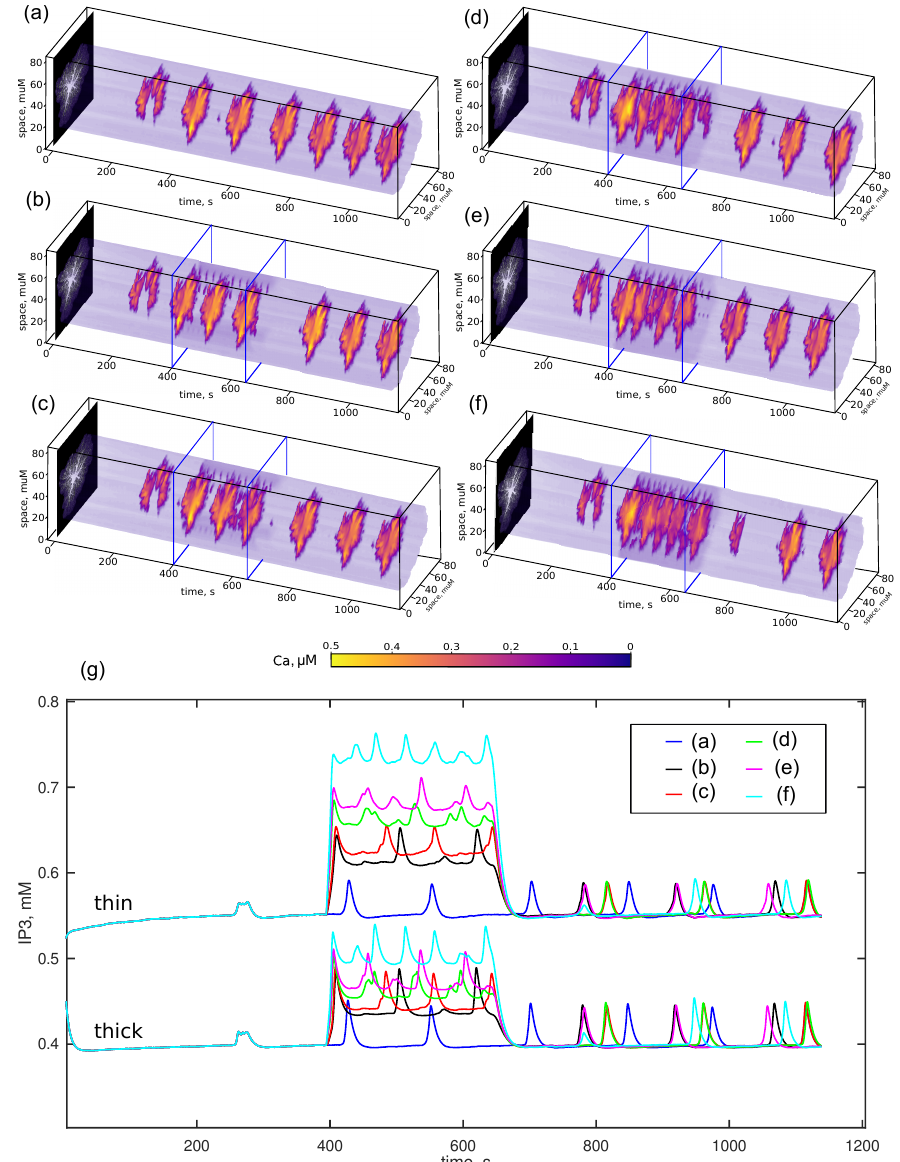
Figure 4. NA effect on astrocytic Ca 2 + under the following cases: ( a )—no NA release; ( b )—additive action of NA; ( c )—cooperative action of NA, facilitating Glu-dependent IP 3 production; ( d – f )— additive action combined with volume NA increase at NA amb = 0.005,0.01,0.05 µ m, respectively. The blue frames in 3D panels indicate the onset and end times of NA release; ( g )—averaged IP 3 time courses for the simulations shown in the panels ( a – f ). The upper and lower groups of curves represent IP 3 concentrations averaged over thin and thick astrocyte processes, respectively. Parameter set 2 was